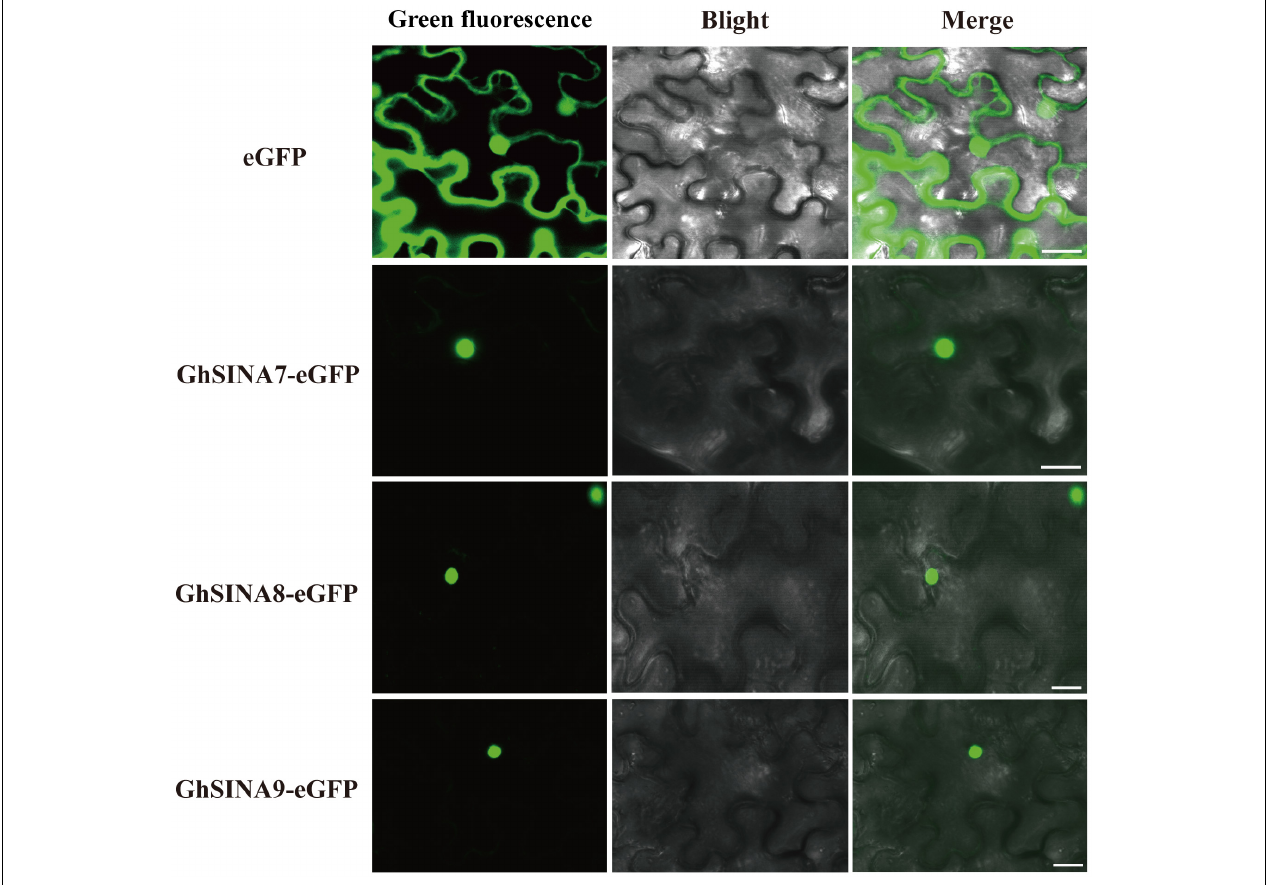
FIGURE 4 | Subcellular localizations of the GhSINA7, GhSINA8, and GhSINA9 proteins in N. benthamiana epidermal cells as assessed by eGFP fusions. The fluorescence signals were visualized using confocal microscopy. Scale bars = 20 µ